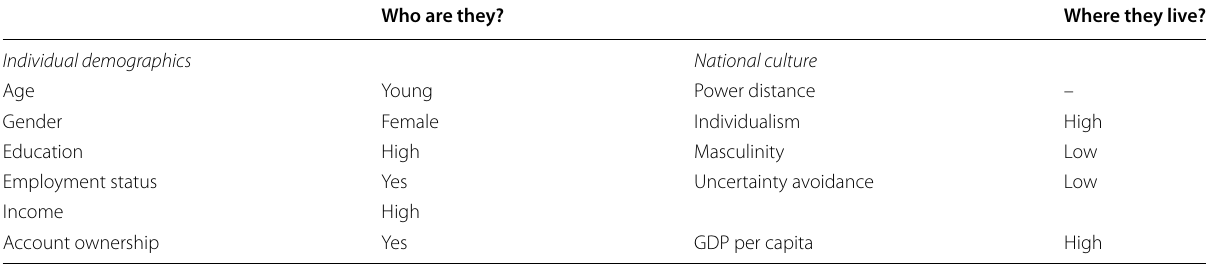
Table 4 Profile of e‑commerce users in ASEAN Who are they? Where they